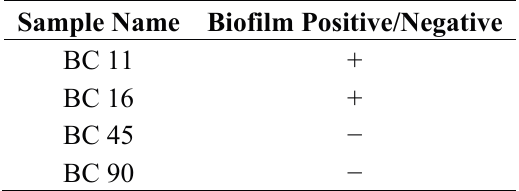
Table 2. Biofilm-positive and negative Candida parapsilosis strains